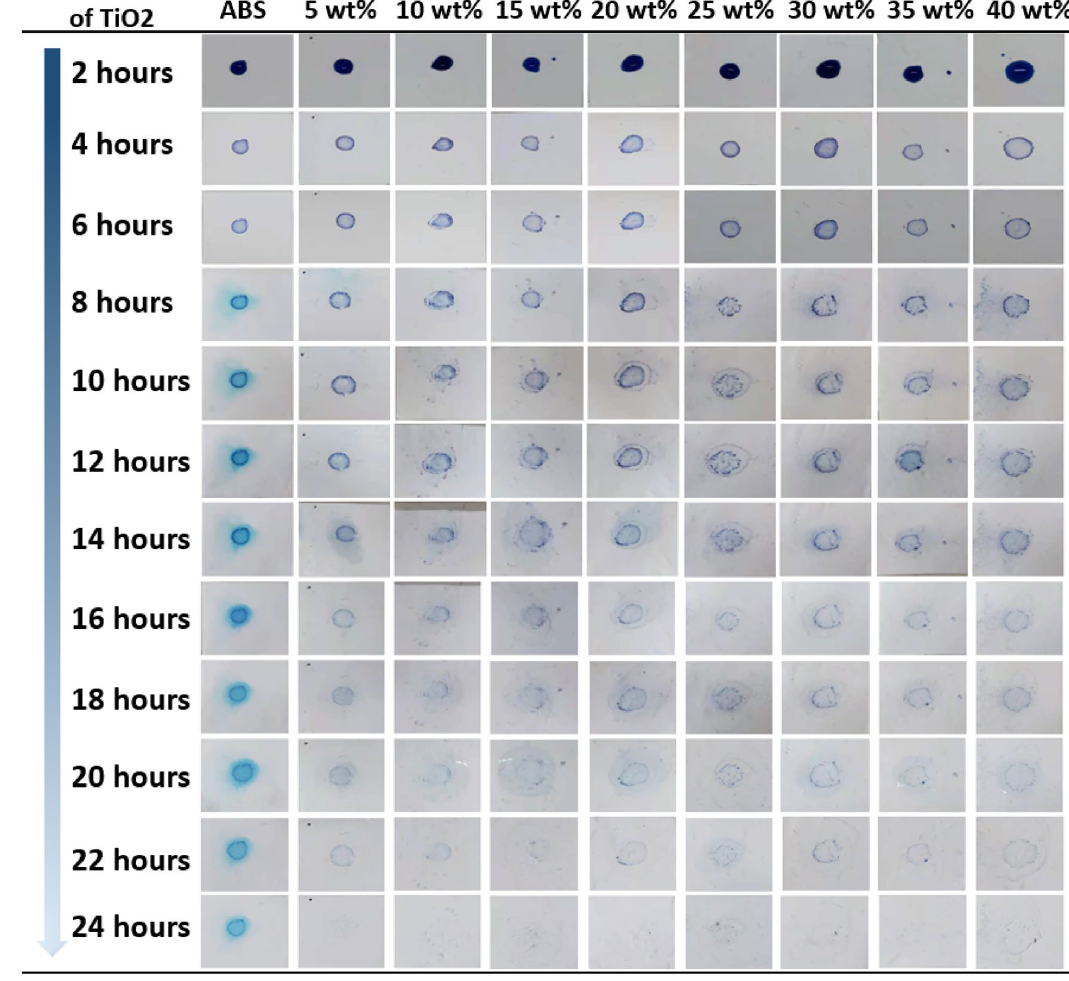
Figure 5. First cycle photographic images (Contamination point 1) showing the discoloration of methylene blue on SCF specimens in an inside-door environment over 24 centrations of TiO 2 increased from 0 to 40 wt%, the anatase peaks intensity increased simultaneously. With the addition of TiO 2 (from 0 to 20 wt%), the anatase peak began to appear. With the increase of TiO 2 concentration (from 20 to 35 wt%), the anatase peaks showed a slow increase trend overall. When the TiO 2 concentration is 40 wt%, the peak value showed lower than 35 wt%. We concluded that the anatase peaks are stronger as the TiO 2 concentration increases. The above trend shows that the addition of TiO 2 and the increase in concentration may affect the crystal structure to a certain extent due to cross-linking 56 .